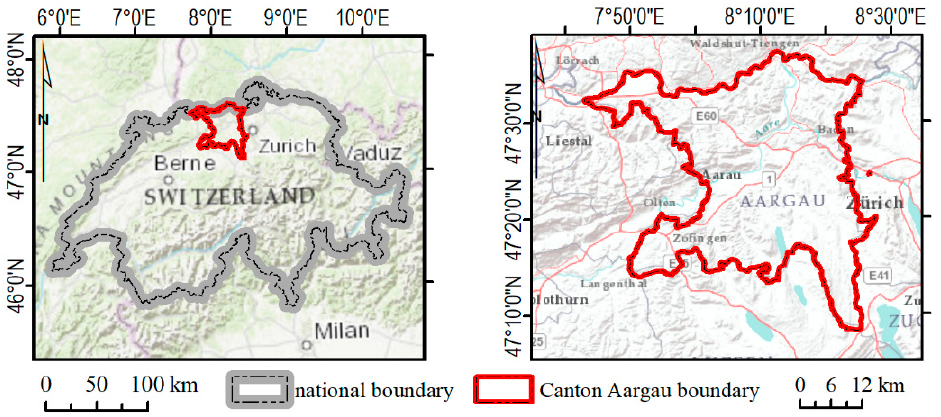
Figure 1. Study area Canton Aargau located in the northern part of Switzerland.